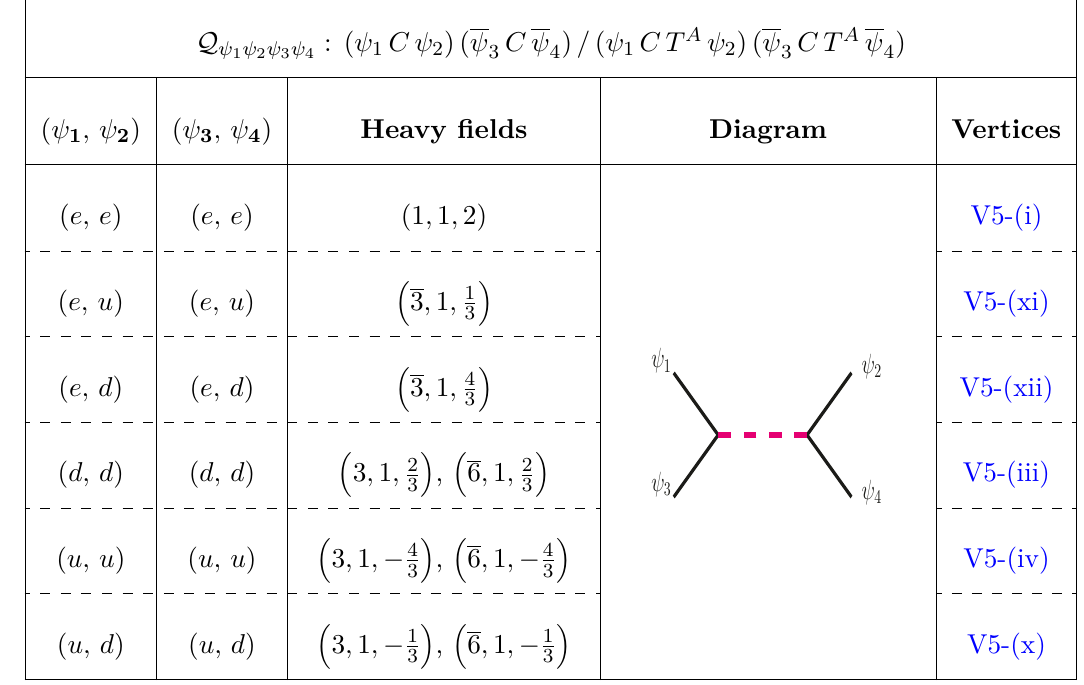
Table 15 . Heavy field representations that are obtained by unfolding the ψ 4 operators, composed of the right chiral SM fermions e , u and d , into a non-trivial tree-level diagram and the corresponding vertices for individual cases. The operators have different fermions as external legs but they unfold through similar diagrams. The table header schematically describes the covariant forms of the